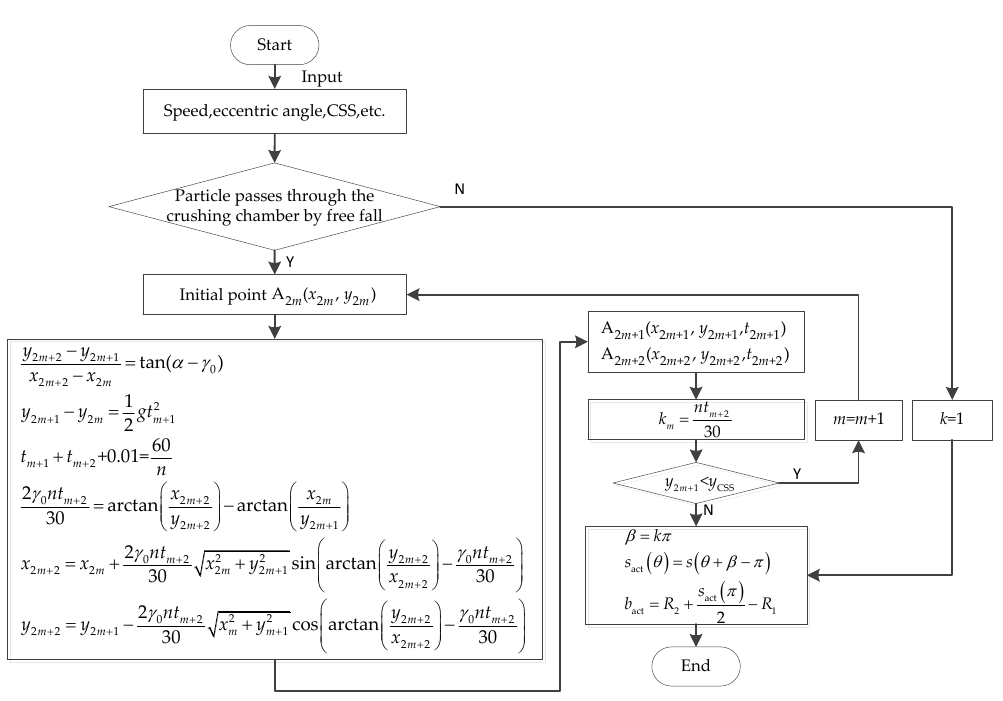
Figure 3. Crushing zone m .